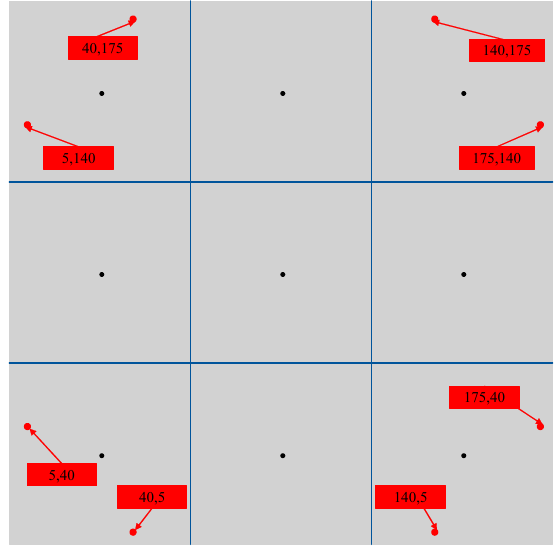
Figure 7. The location of the receiving point on the surface of the aluminum plate.